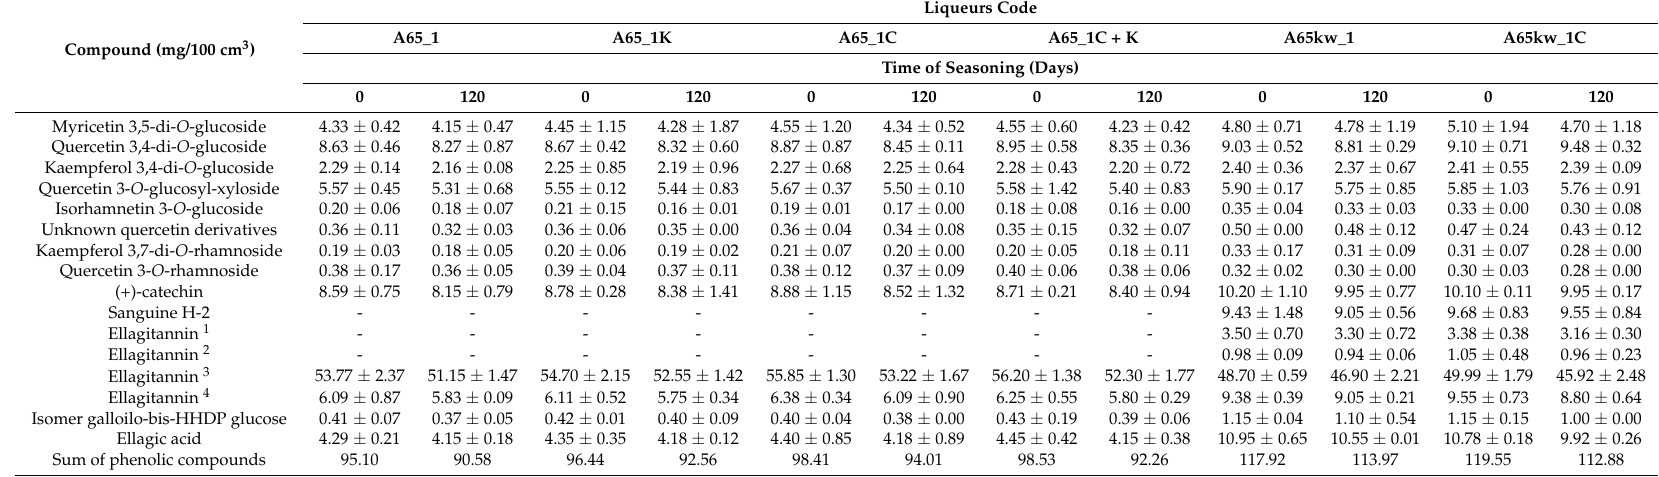
Table 3. Content of polyphenolic compounds in liqueurs from Rosa rugosa petals macerated with 65% ethanol, during 120 days of